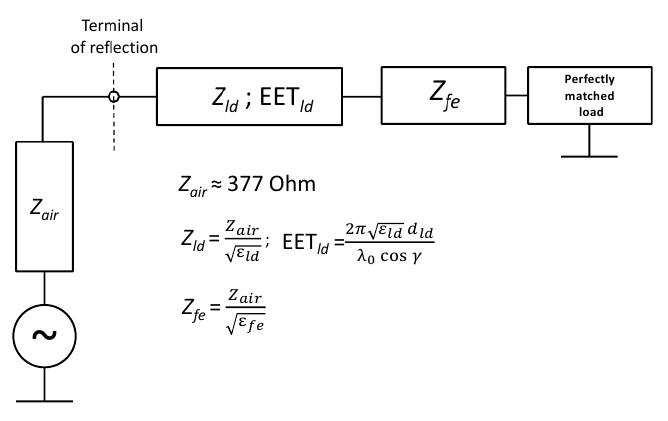
Figure 4. Equivalent electrical circuit for the calculation of the reflection coefficient.